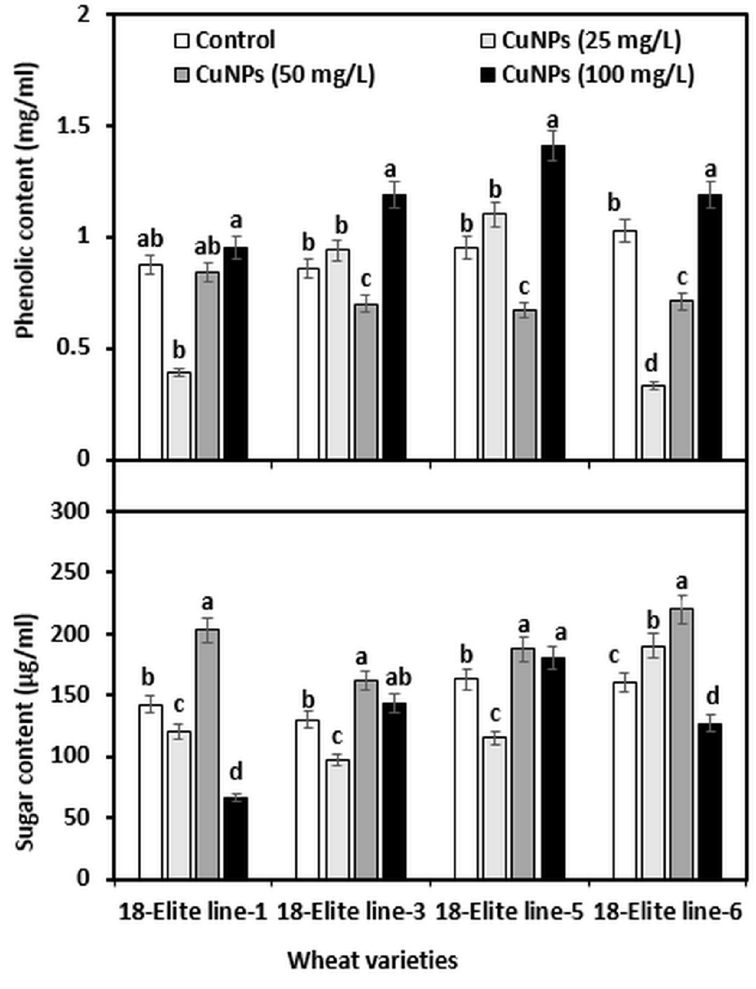
Fig 7. Total phenolic content and total soluble sugar content of 10 days wheat seedlings affected by different concentration of CuNPs. Different letters in the same sub-group of columns indicate significant difference at p < 0.05